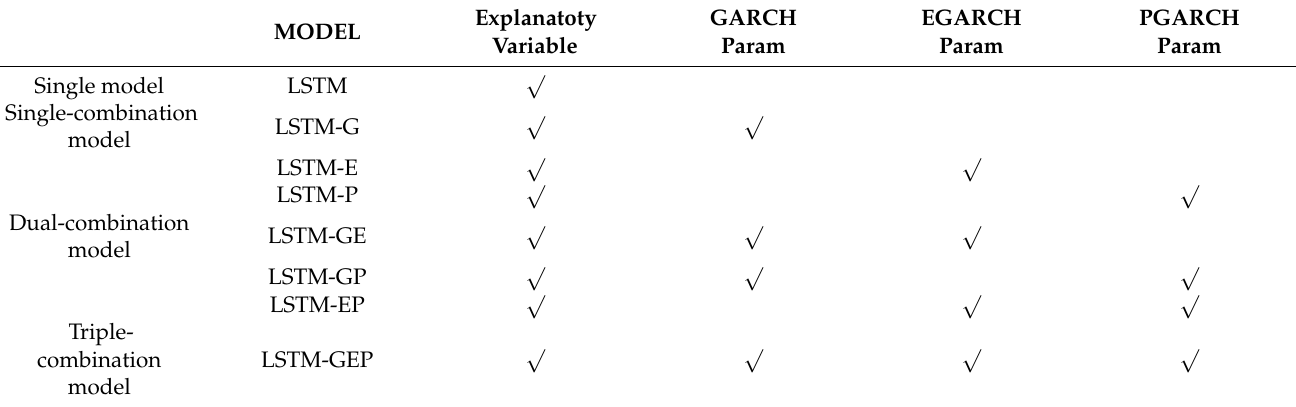
Table 4. Input-layer variables of each